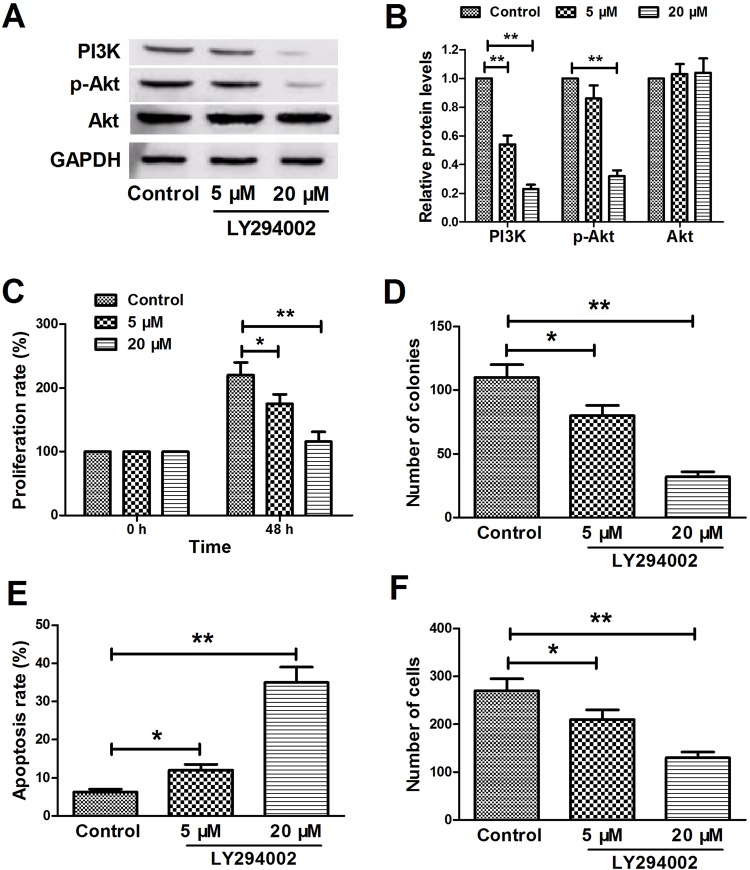
Blocking the PI3K/AKT pathway inhibits YTS cell proliferation and invasion and promotes apoptosis. (A,B) Western blot analysis revealed that LY294002 treatment (5 μM and 20 μM) significantly suppressed p-AKT and PI3K in a dose-dependent manner, while AKT expression in the three experimental groups was not significantly different. (C) CCK-8 assay showed that LY294002 treatment had an inhibitory effect on cell proliferation of YTS cells in a dose-dependent manner at 48 h. (D) Colony formation assay showed that LY294002 treatment caused a decrease in the clonogenic survival of YTS cells in a dose-dependent manner. (E) Flow cytometric analysis exhibited that LY294002 treatment had a promotive effect on proliferation of YTS cells in a dose-dependent manner at 48 h. (F) Transwell invasion assay showed that LY294002 treatment had an inhibitory effect on the cell invasion ability of YTS-GSN cells in a dose-dependent manner at 48 h. *P<0.05,**P<0.01.